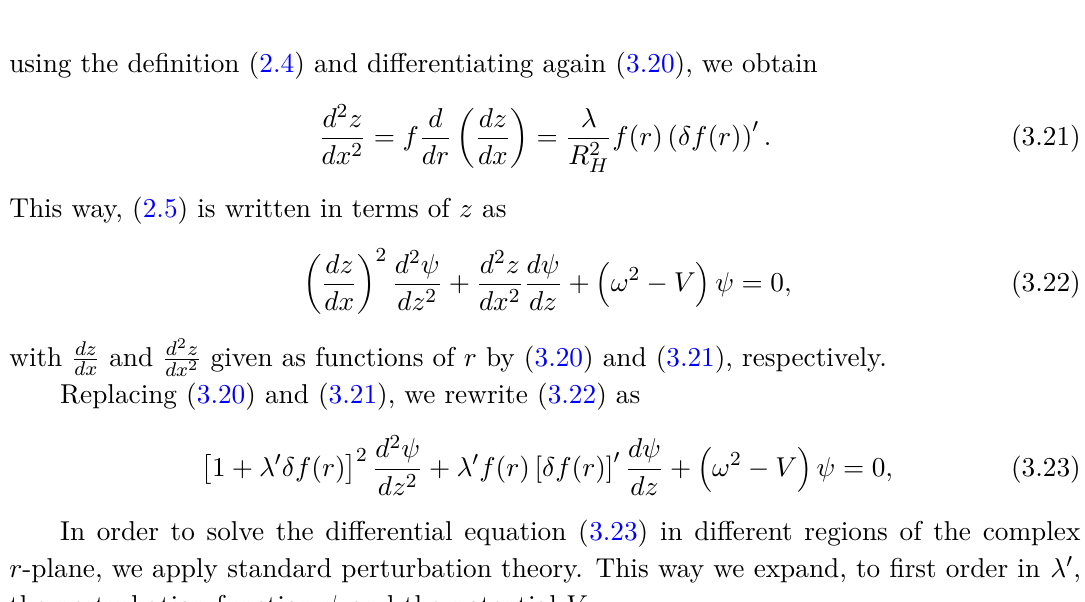
) . We denoted the positions of the H